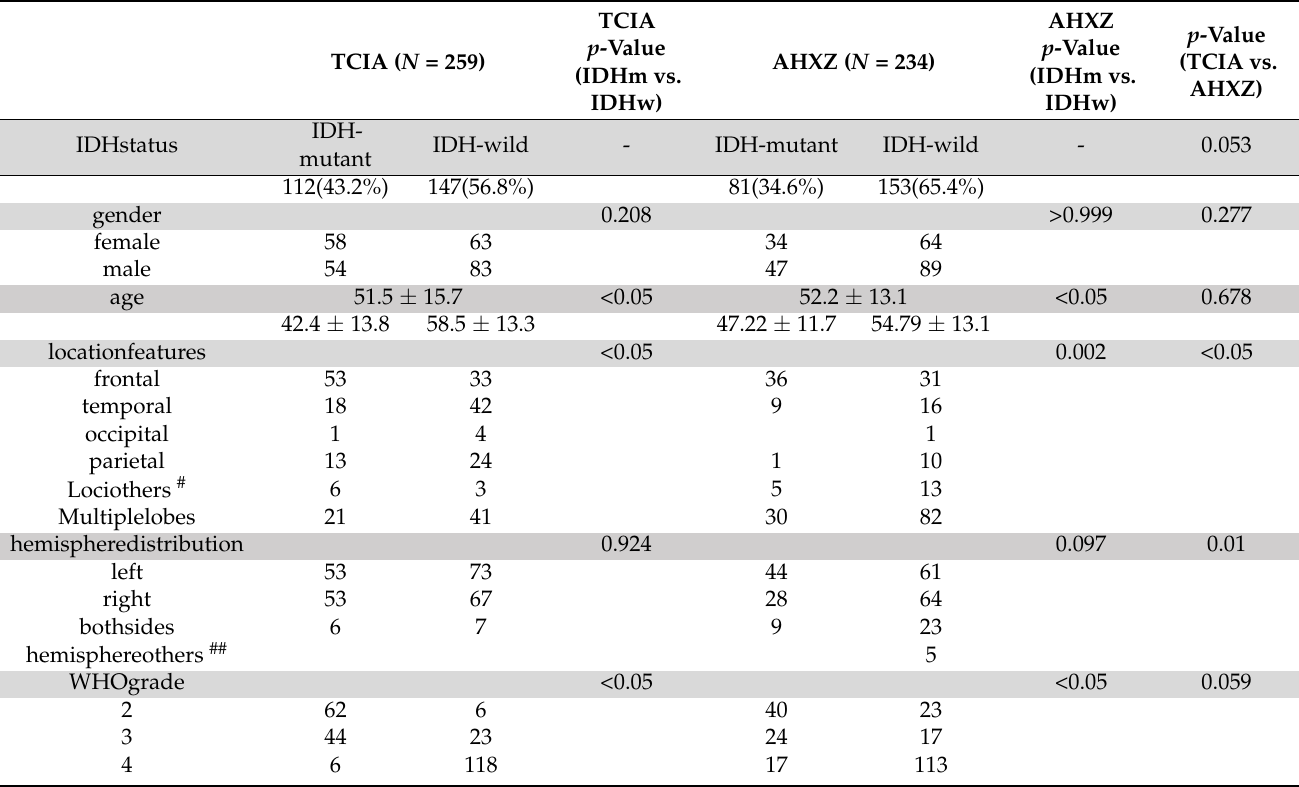
Table 2. Patient